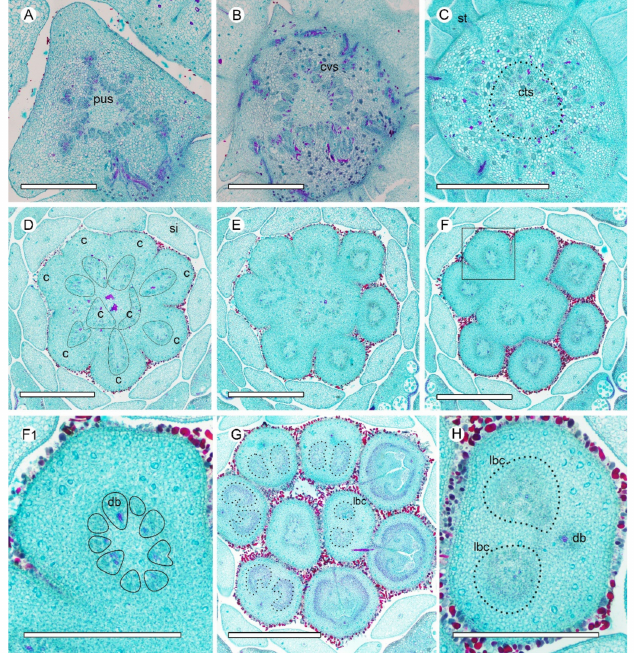
Figure 4. Ascending paraffin transections of Anaxagorea javanica flower. ( A ) Base of receptacle, showing six groups of vascular bundles and sepal connections. ( B ) Points of petal connection to receptacle, showing perianth bundles. ( C ) Androecial bundles serving stamens by repeated branching. ( D , E ) Base of gynoecium, showing enlarged central stele breaks and bundles distributed into carpels (bundles of each carpel is marked by a solid line). ( F , G ) Carpel vasculature at different positions. ( F1 ) Detailed view of a carpel in F (marked with a box), showing vascular bundles making up the basal ring (each bundle is marked by a solid line). ( H ) Concentric lateral bundle complexes in carpel. C, carpel; cts, central stele; cvs, cortical vascular system; db, dorsal bundle; lbc, lateral bundle complex; pus, pseudostele; si, staminode; st, stamen. Scale bars = 500 µ